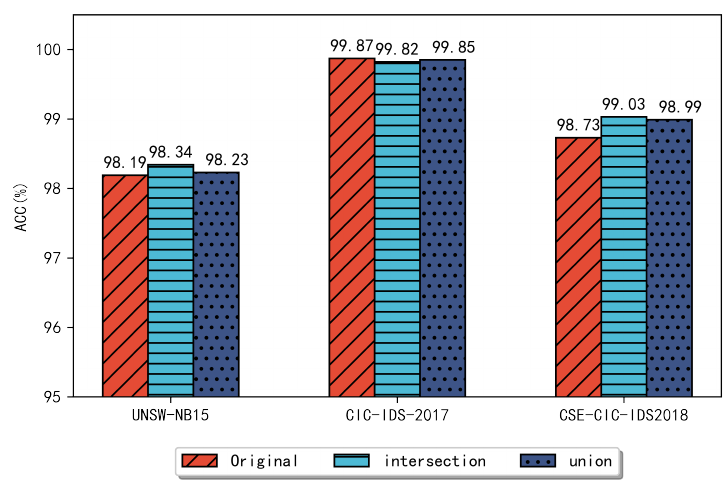
Figure 6. Using a DT classifier to compare the accuracy of several